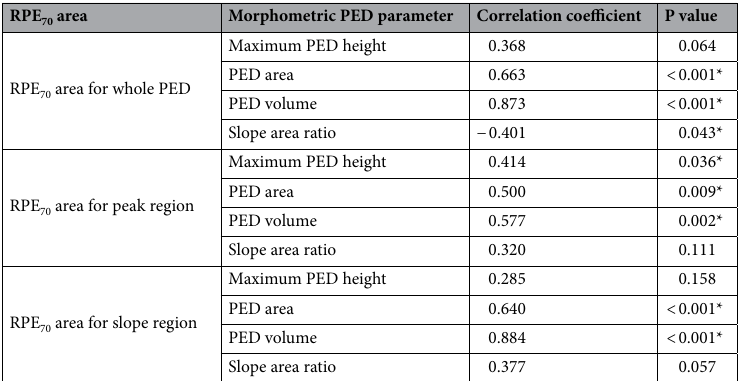
Table 2. Correlations between RPE 70 areas and morphometric retinal pigment epithelial detachment parameters. PED pigment epithelial detachment, RPE retinal pigment epithelium. *Statistically significant